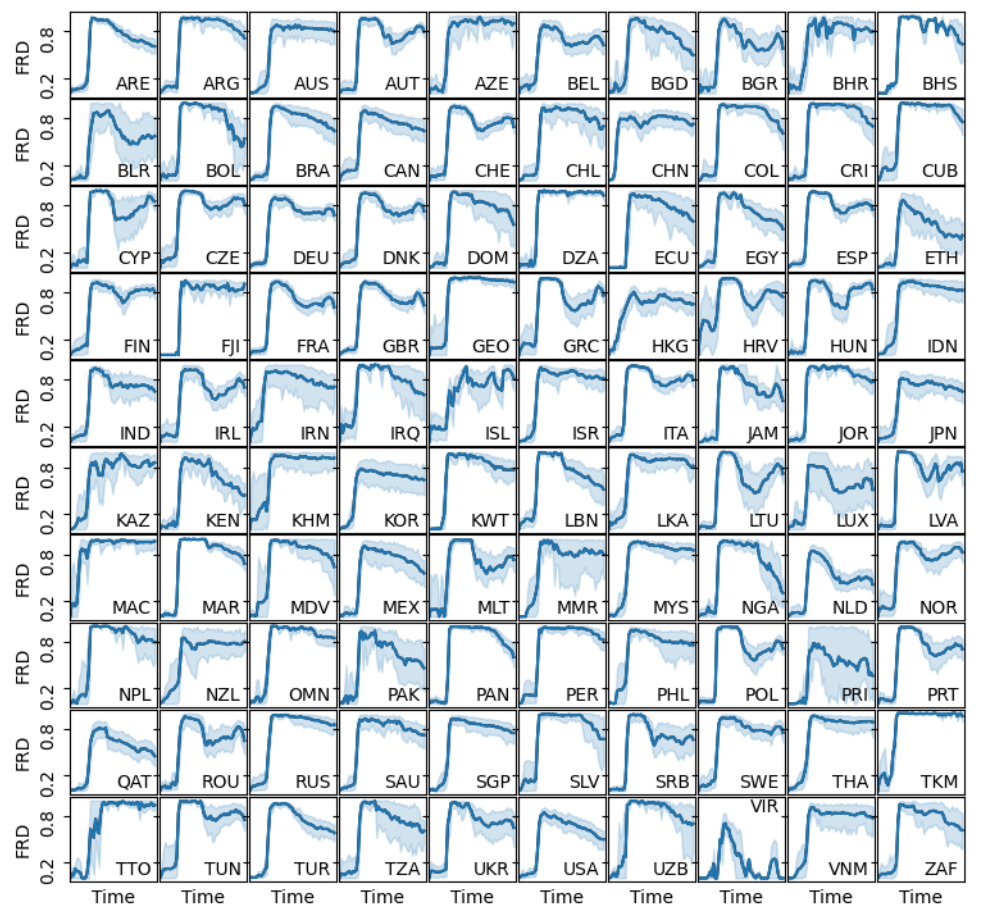
Figure 4. Temporal evolution of flight ratio discrepancy for the top 100 countries in this study. Solid blue lines represent the average FRD; shaded areas represent the 95% confidence interval over all destinations of a country.